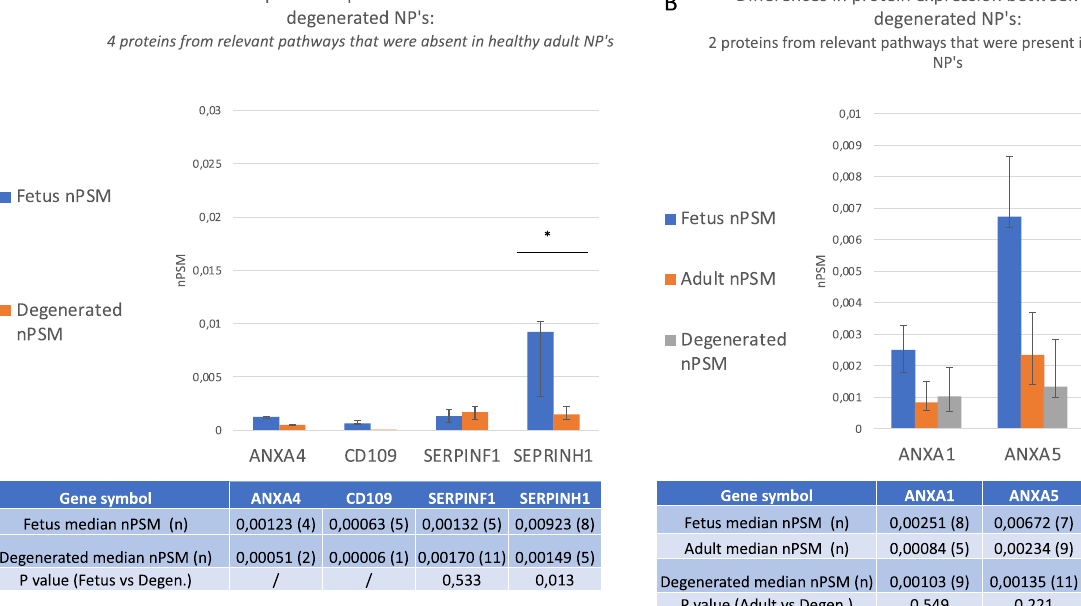
Figure 4. Additional comparison with degenerated samples for the proteins significantly upregulated in anabolic pathways. ( A ) Includes the proteins that were absent in healthy adult NP’s, and shows differences in protein expression between fetus and degenerated discs. ( B ) Includes the proteins that were expressed in a significantly lower amount in healthy adult NP’s compared to fetus and shows the differences in protein expression between healthy adult and degenerated discs. The Y axis displays median normalized PSM’s per group, X axis shows protein gene symbols, error bars are Interquartile ranges and * indicates statistical significance. The attached table contains the median (number of samples) for each group, and provides the according Mann Whitney U p values if statistics could be performed (n ≥ 4). ‘/’ indicates that 3 or less samples were present in one of the groups and no statistical test could be